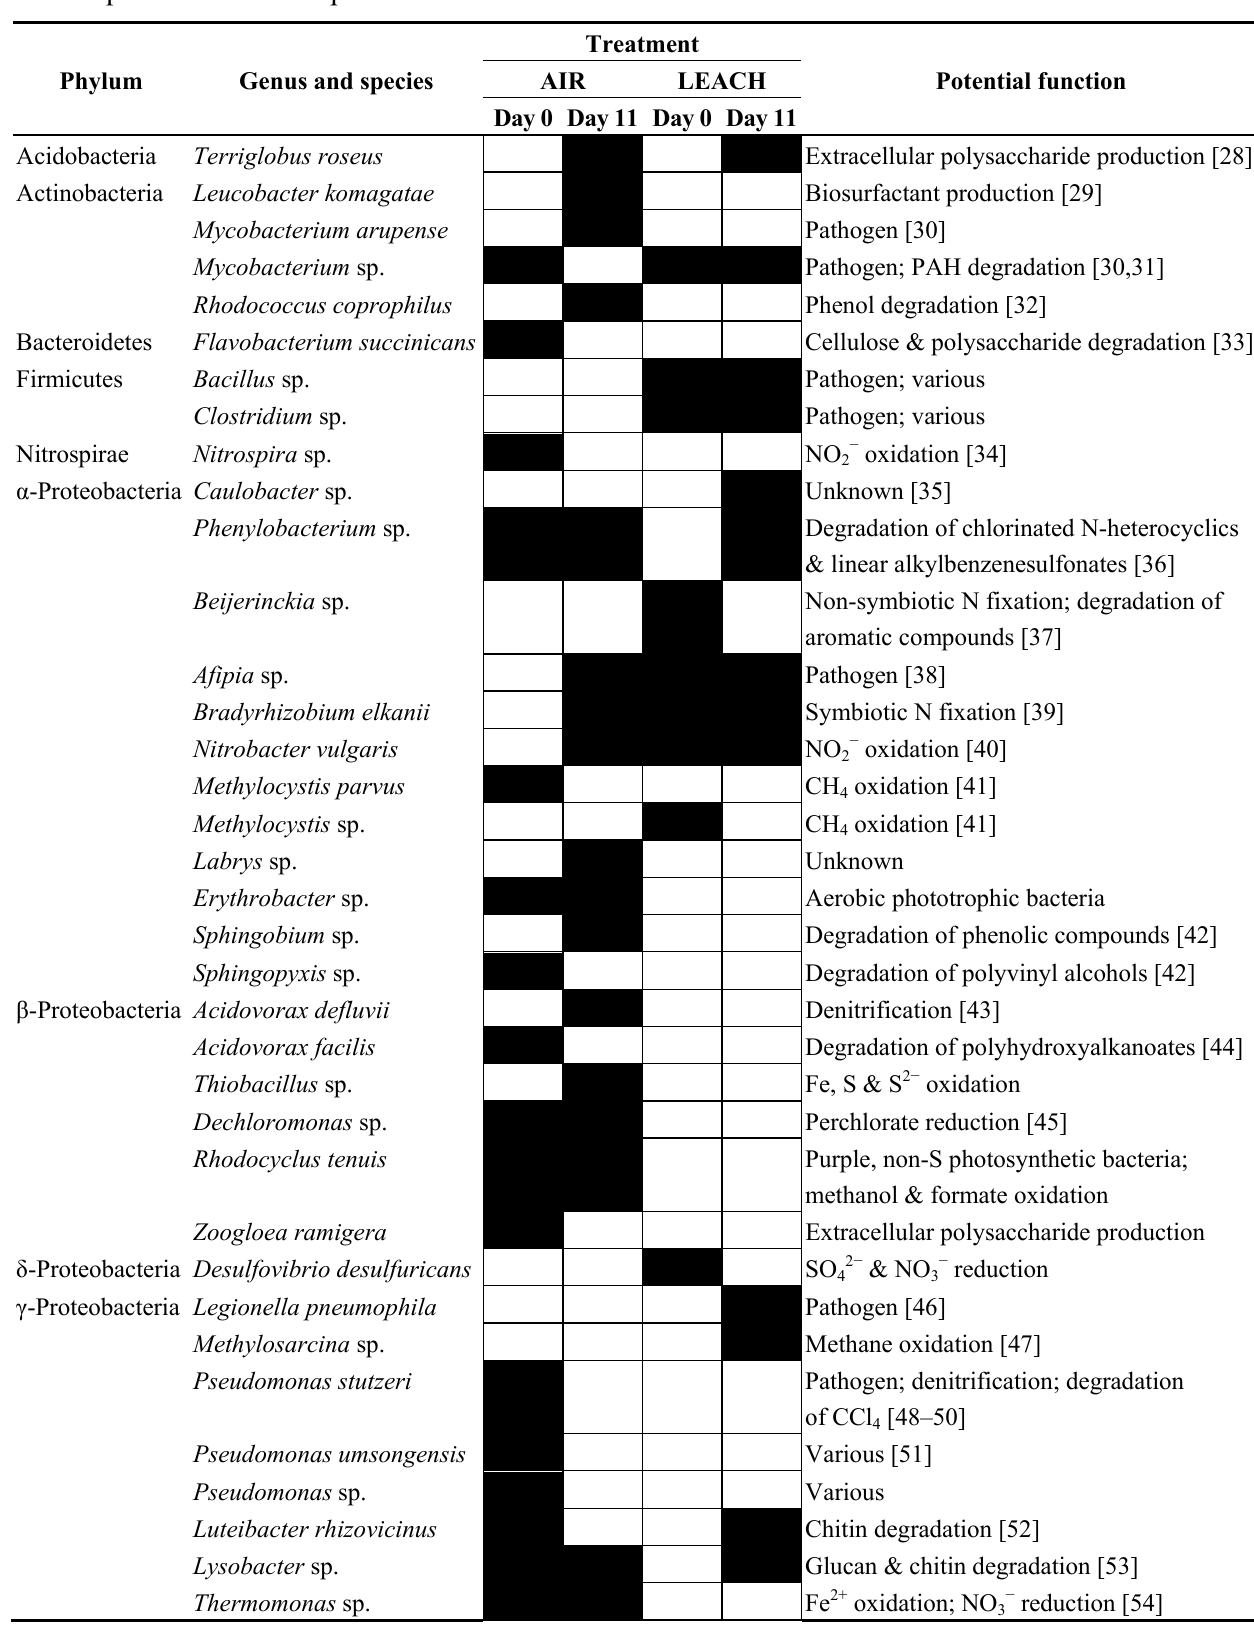
Table 3. Phylum, genus and species (closest match; similarity ≥ 97%) and potential function for OTUs from intermittently aerated (AIR) and unaerated (LEACH) soil from leachfield mesocosms before (Day 0) and after (Day 11) dosing with tetracycline. Dark squares indicate the presence of an OTU in a